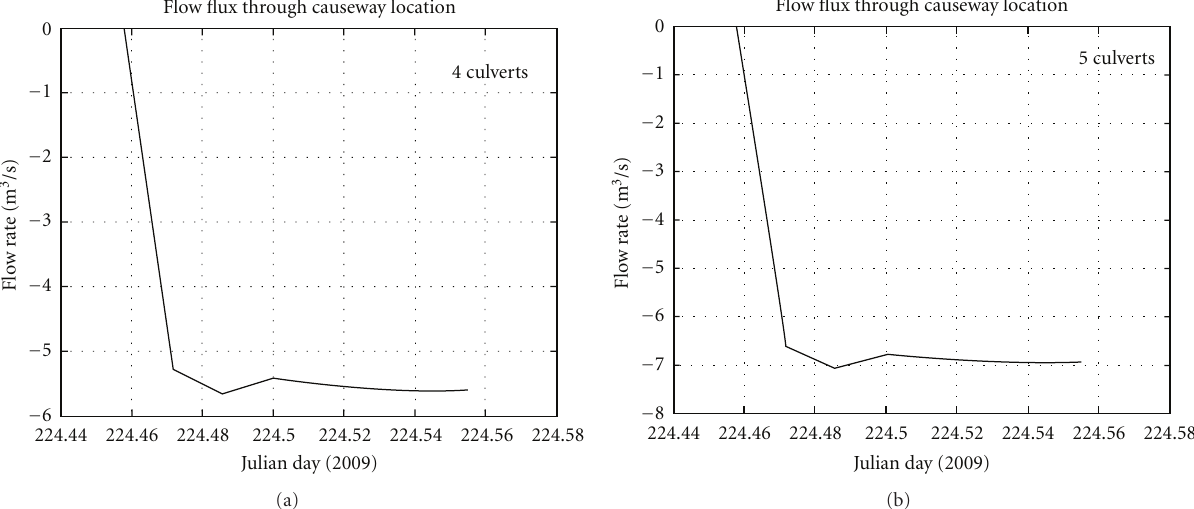
Figure 24: The exchange flow rates through the causeway under the 4 or 5 culvert configurations and natural wind.